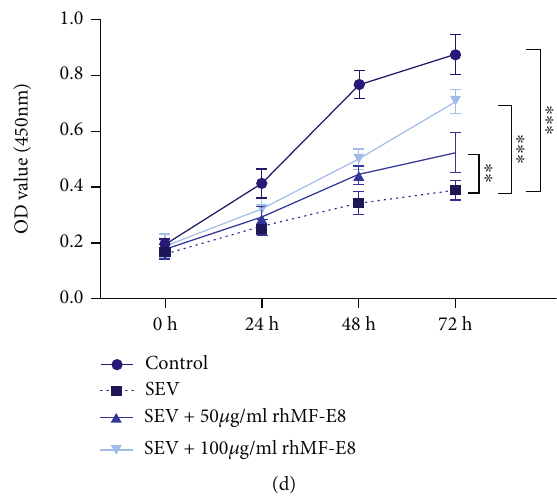
Figure 1: The expression of MFG-E8 a ff ected by SEV and CA on cell viability NSCs were exposed to 4.1% SEV for 2h per day for 3 consecutive days). (a) The mRNA expression of MFG-E8 was a ff ected by sevo fl urane for 0, 24 h, 48 h, and 72 h. (b) The protein expression of MFG-E8 was a ff ected by sevo fl urane for 0, 24h, 48 h, and 72 h. (c) The protein expression of MFG-E8 was a ff ected by sevo fl urane, sevo fl urane+50 μ g/ml rhMFG-E8, and sevo fl urane+100 μ g/ml rhMFG-E8. (d) The OD value at 450 nm was detected by MTT assay after treatment with sevo fl urane, sevo fl urane+50 μ g/ml rhMFG-E8 and sevo fl urane+100 μ g/ml rhMFG-E8 for 0, 24h, 48h, and 72 h. ∗ p < 0 : 005 , ∗∗ p < 0 : 001 , ∗∗∗ p < 0 : 0001 ( n = 3